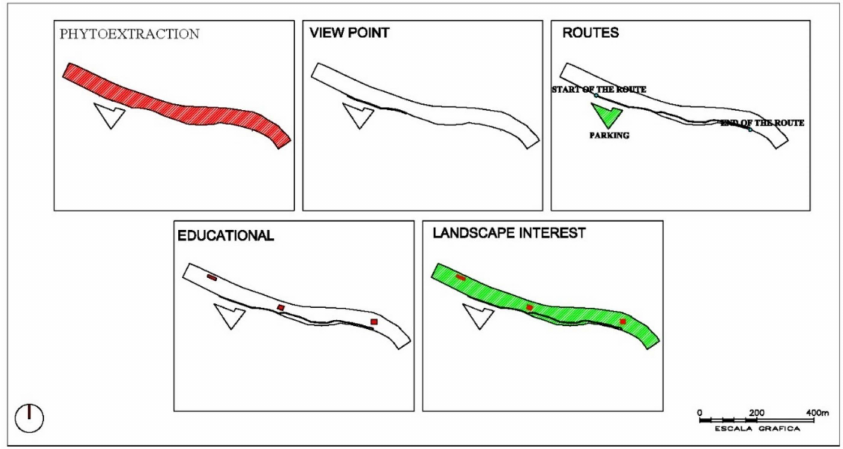
Figure 7. Detailed location of the landscape characterizations by uses, for Case Study